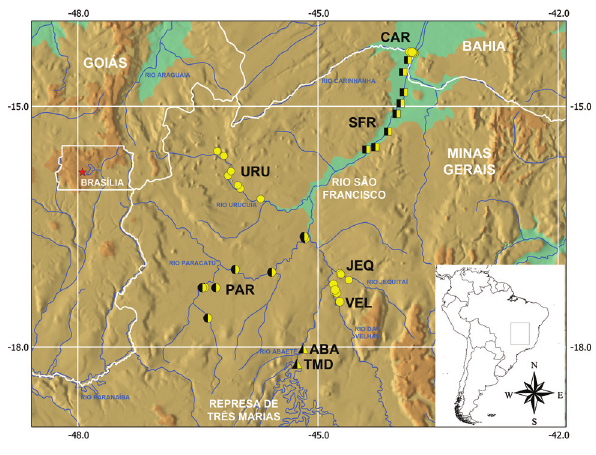
Fig. 1. Map showing the central portion of the rio São Francisco basin and the distribution of the samples of Prochilodus argenteus (yellow) and of P. costatus (black). The circles represent marginal lagoons from tributaries, squares represent marginal lagoons from the rio São Francisco, and triangles represent places in the mainstream rio São Francisco in the Três Marias region. ABA = rio Abaeté; CAR = rio Carinhanha lagoons; JEQ = rio Jequitaí lagoons; PAR = rio Paracatu lagoons; SFR = rio São Francisco lagoons; URU = rio Urucuia lagoons; VEL = rio das Velhas lagoons; TMD = Três Marias